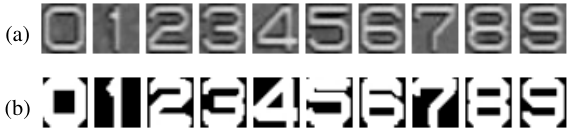
Figure 5: Digits (a) and masks (b) utilised by the digit classification